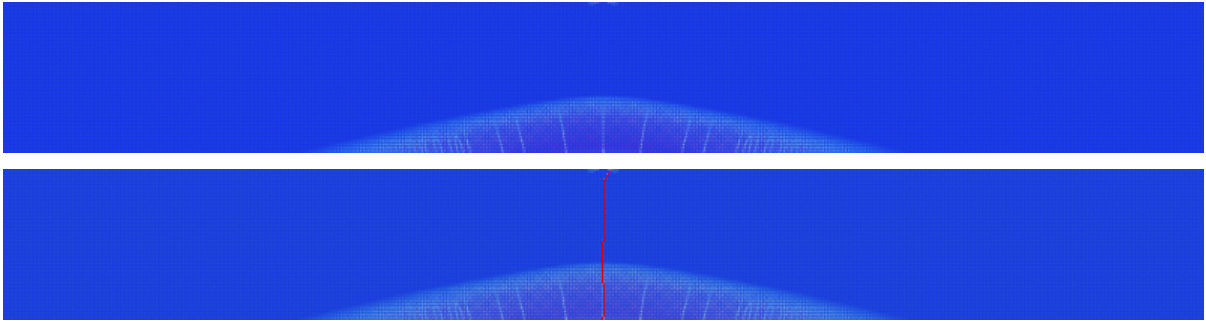
Figure 5. The damage (red) in bonds computed with full lattice model: evolution of the process zone one step before crack initiation (top) and final process zone and fully developed crack path in the last step of simulation